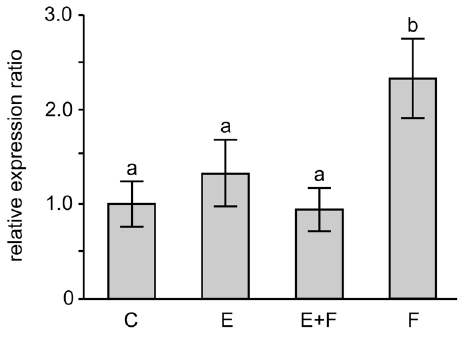
Figure 1. Expression ratios of FMO GS-OX2 in leaves subjected to different oviposition and feeding treatments. Values are means 6 standard errors of wild-type Arabidopsis thaliana plants (Col-0). C: untreated control leaves ( N =8); E: leaves on which eggs were laid and left for 5 days ( N =8); E + F: leaves on which eggs were laid and caterpillars hatched and fed for 2 days ( N =7); F: leaves that never had eggs but were fed on for 2 days ( N =7). Data were normalised to the amplification of ubiquitin, calibrated against the value of the control, and statistically evaluated by analyses of variance (ANOVA). Different letters above the columns indicate significant differences by means